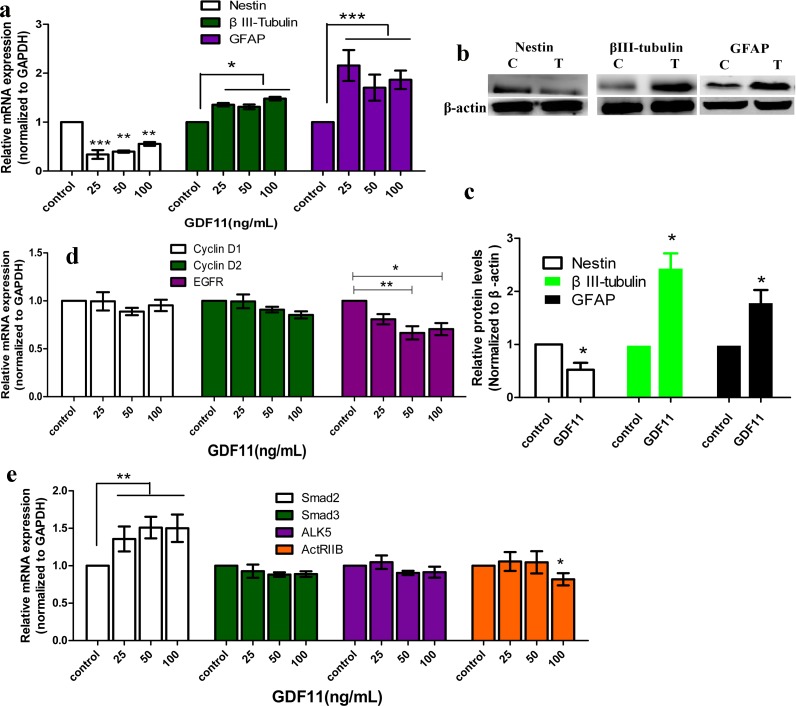
The effect of GDF11 on mRNA and protein expression.(A) Nestin, βIII-tubulin and GFAP mRNA levels of C17.2 cells after GDF11 or vehicle (control) treated for 5 h.The results display mean ±SD of n = 4 and were analysed by one-way ANOVA followed by Tukey’s post hoc test. *p < 0.05 as compared with mRNA levels in control cells. (B) Nestin, βIII-tubulin and GFAP protein levels of C17.2 cells after GDF11 (50 ng/mL, “T”) or vehicle (“C”) treated for 72 h. (C) Quantitative analyses of protein expression in relation to β-actin expression. Results were analysed by Student’s t-test. N = 6, *p < 0.05. (D) Cyclin D1, Cyclin D2 and EGFR mRNA expression after GDF11 or vehicle treated for 5 h. N = 5, *p < 0.05 and **p < 0.01. (E) The mRNA levels of Smad2, Smad3, Alk5 and ActRIIB after GDF11 or vehicle treated for 5 h. N = 5, *p < 0.05 and **p < 0.01.